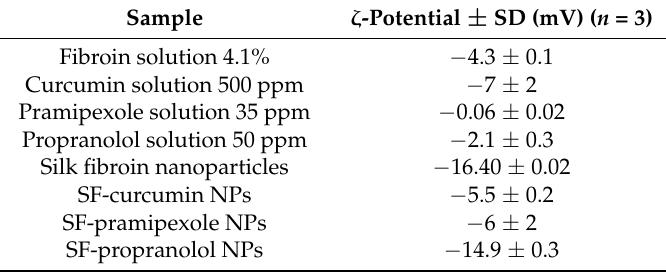
Table 4. ζ -potential of model drug solutions, silk fibroin nanoparticles, and drug-encapsulated silk fibroin